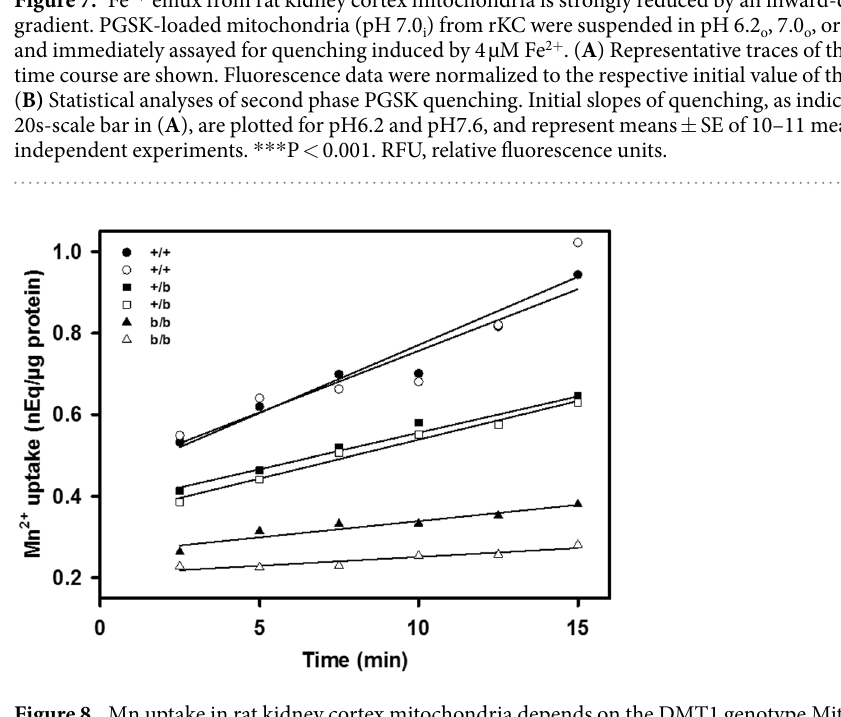
Figure 8. Mn uptake in rat kidney cortex mitochondria depends on the DMT1 genotype.Mitochondria were isolated from two rats of each of 3 genotypes ( b/b indicating homozygous Belgrade rats with a G185R mutation, + / b indicating heterozygous rats and + / + indicating wild-type animals) then incubated with 54 Mn 2 + for the times indicated and incorporation was determined. ANOVA for incorporation based on time, genotype or time/genotype interaction indicated differences for each comparison, P < 0.00005 in all cases as well as for all pairwise genotype comparisons. Designating the mean + / + slope = 1.0, then one + / + rat’s slope = 1.05; the other + / + rat’s slope = 0.95; one + / b rat’s slope = 0.56; the other + / b rat’s slope = 0.60; one b / b rat’s slope = 0.25 and the other b / b rat’s slope =